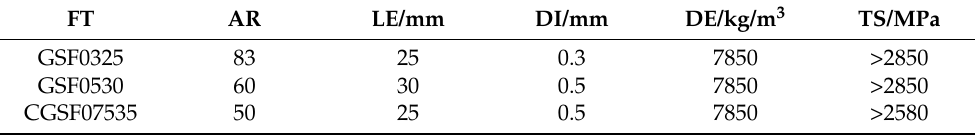
Table 4. Main performance indicators of steel